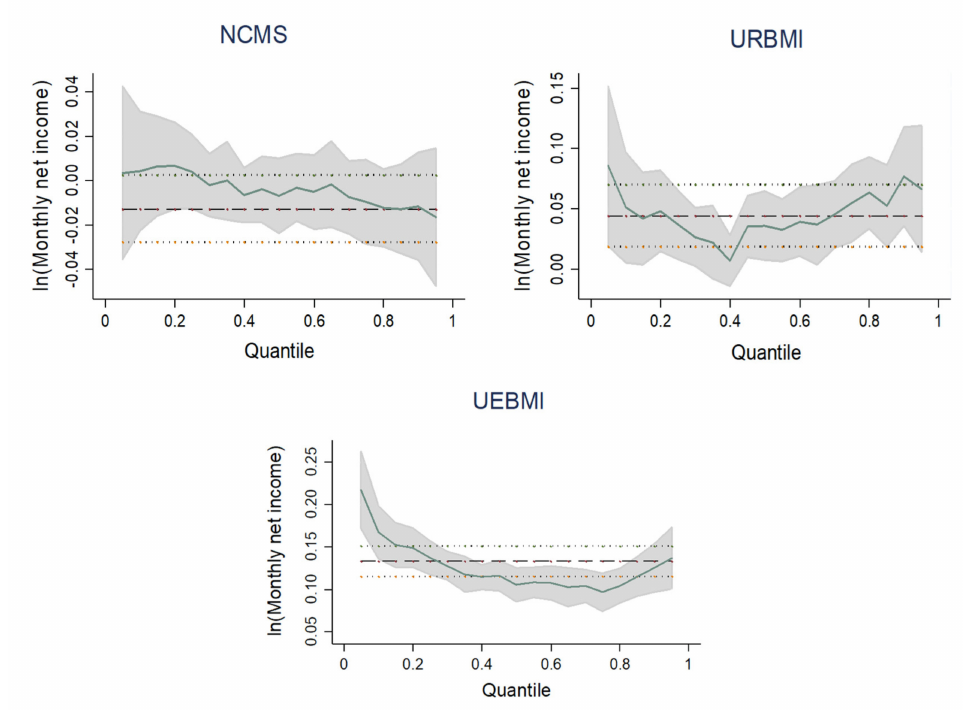
Figure 2. Quantile regression estimates for the three health insurance